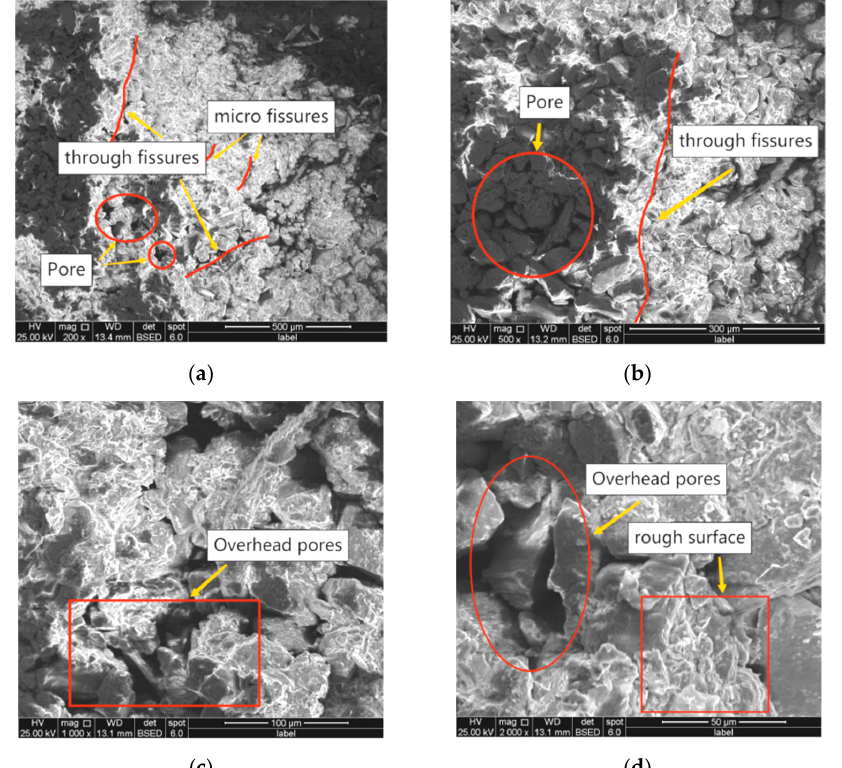
Figure 7. A-0 microscopic image of soil sample: ( a ) 200 times; ( b ) 500 times; ( c ) 1000 times; ( d ) 2000 times.